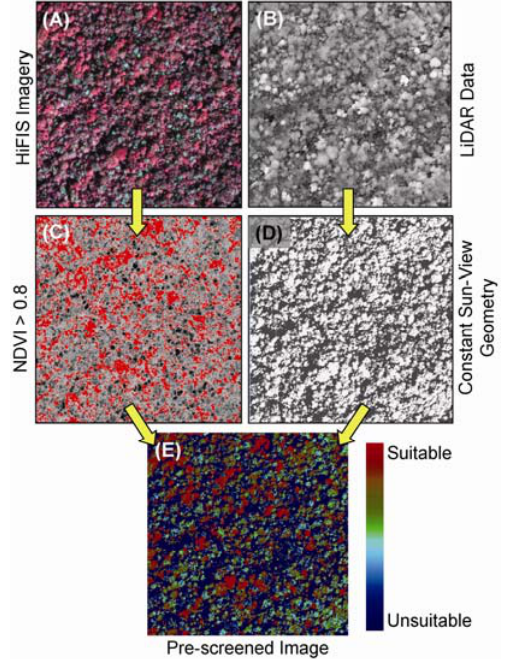
Figure 4. Fully integrated (A) hyperspectral and (B) LiDAR instrumentation provides a means to filter rainforest canopies into comparable units for mapping invasive species. (C) Simple pre-screening of the data based on a minimum NDVI, here set to 0.8, ensures that only foliated canopies are analyzed (red color). (D) Sun-target-view geometry (here, 20°) and minimum canopy height (here, 5 m) is controlled for using the LiDAR data thus pre- screening for view angle effects (white color). (E) Combined, these filters provide a map of canopies suitable for species determinations and comparison. These example images were collected over a Hawaiian rainforest reserve. Adapted from Asner and Martin [77] with permission from